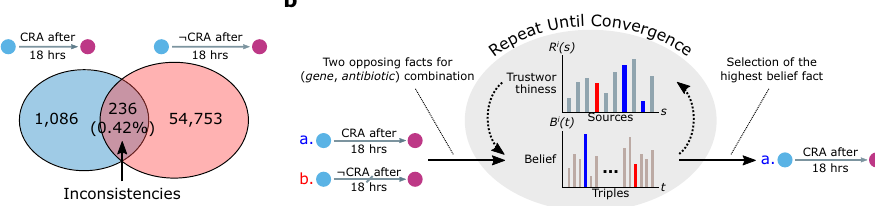
Fig. 3 Inconsistency resolution. a Venn diagram showing the inconsistencies detected in the intermediate knowledge graph, where the inconsistency is de fi ned as two or more sources supporting a con fl icting fact. b The inconsistency resolution algorithm is iteratively trained using the intermediate knowledge graph. Once the training converges, it is used to select the triple with the higher belief among the inconsistencies. See Methods for more details. The blue and purple nodes represent gene and antibiotic, respectively. CRA denotes the predicate ‘ confers resistance to antibiotic ’ , whereas ¬ CRA denotes ‘ confers no resistance to antibiotic ’ fl hDC 61 and induces the expression of the gltBD operon, which is involved in acid resistance 62,63 . Lrp encodes a leucine-responsive regulatory protein, which regulates at least 10% of the genes in E.